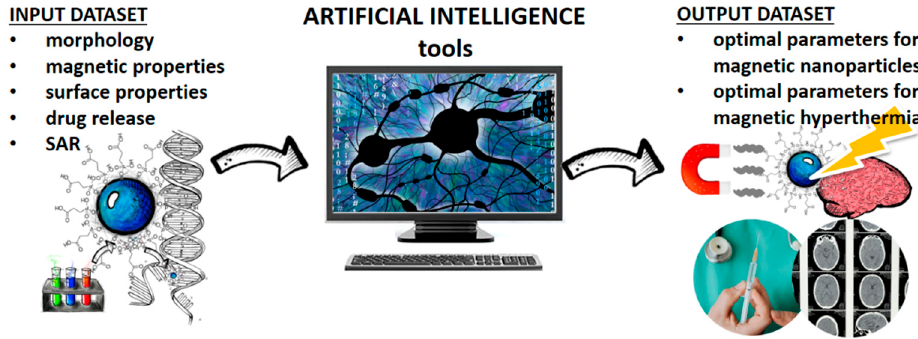
Figure 1. The general idea of magnetic hyperthermia combined with AI is applied to tumor thera-